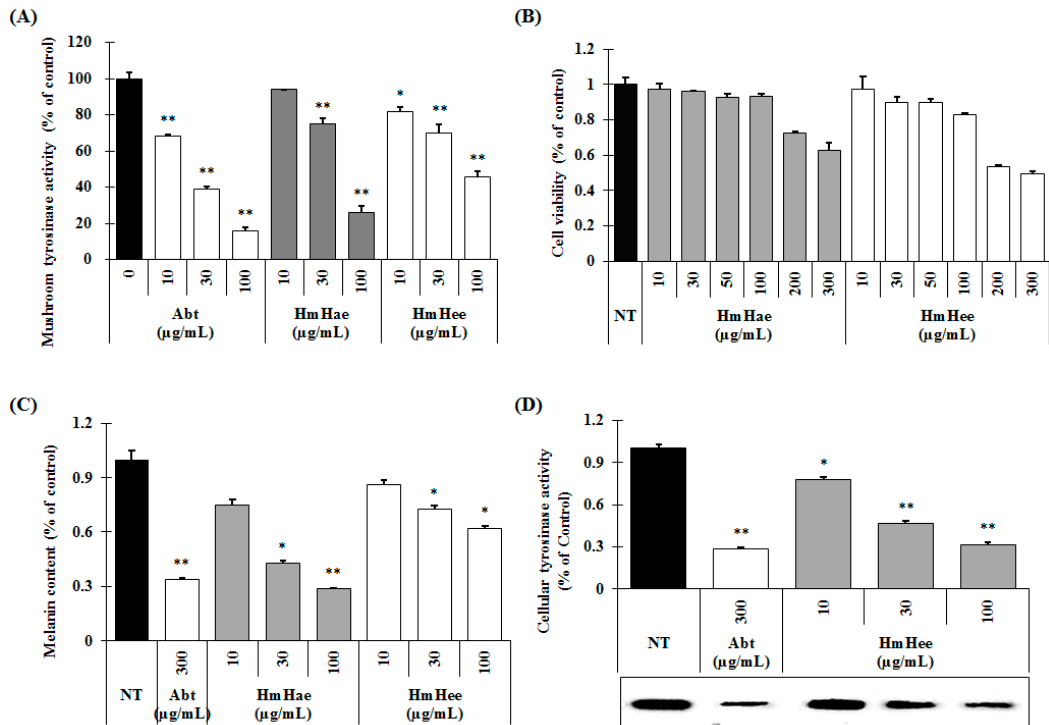
Figure 3. Inhibitory effects of HmHe leaf extracts on mushroom tyrosinase activity, melan-a cell viability, melanin content, and intracellular tyrosinase activity. ( A ) Different concentrations of the leaf extracts (10, 30, and 100 µ g/mL) or arbutin were incubated with the same units of mushroom tyrosinase. Following incubation, the amount of dopachrome produced was determined at 490 nm spectrophotometrically; ( B ) Cells (1 × 10 5 cells/mL) were seeded overnight, and the medium replaced with fresh medium containing the indicated concentrations of HmHae and HmHee or Arbutin.